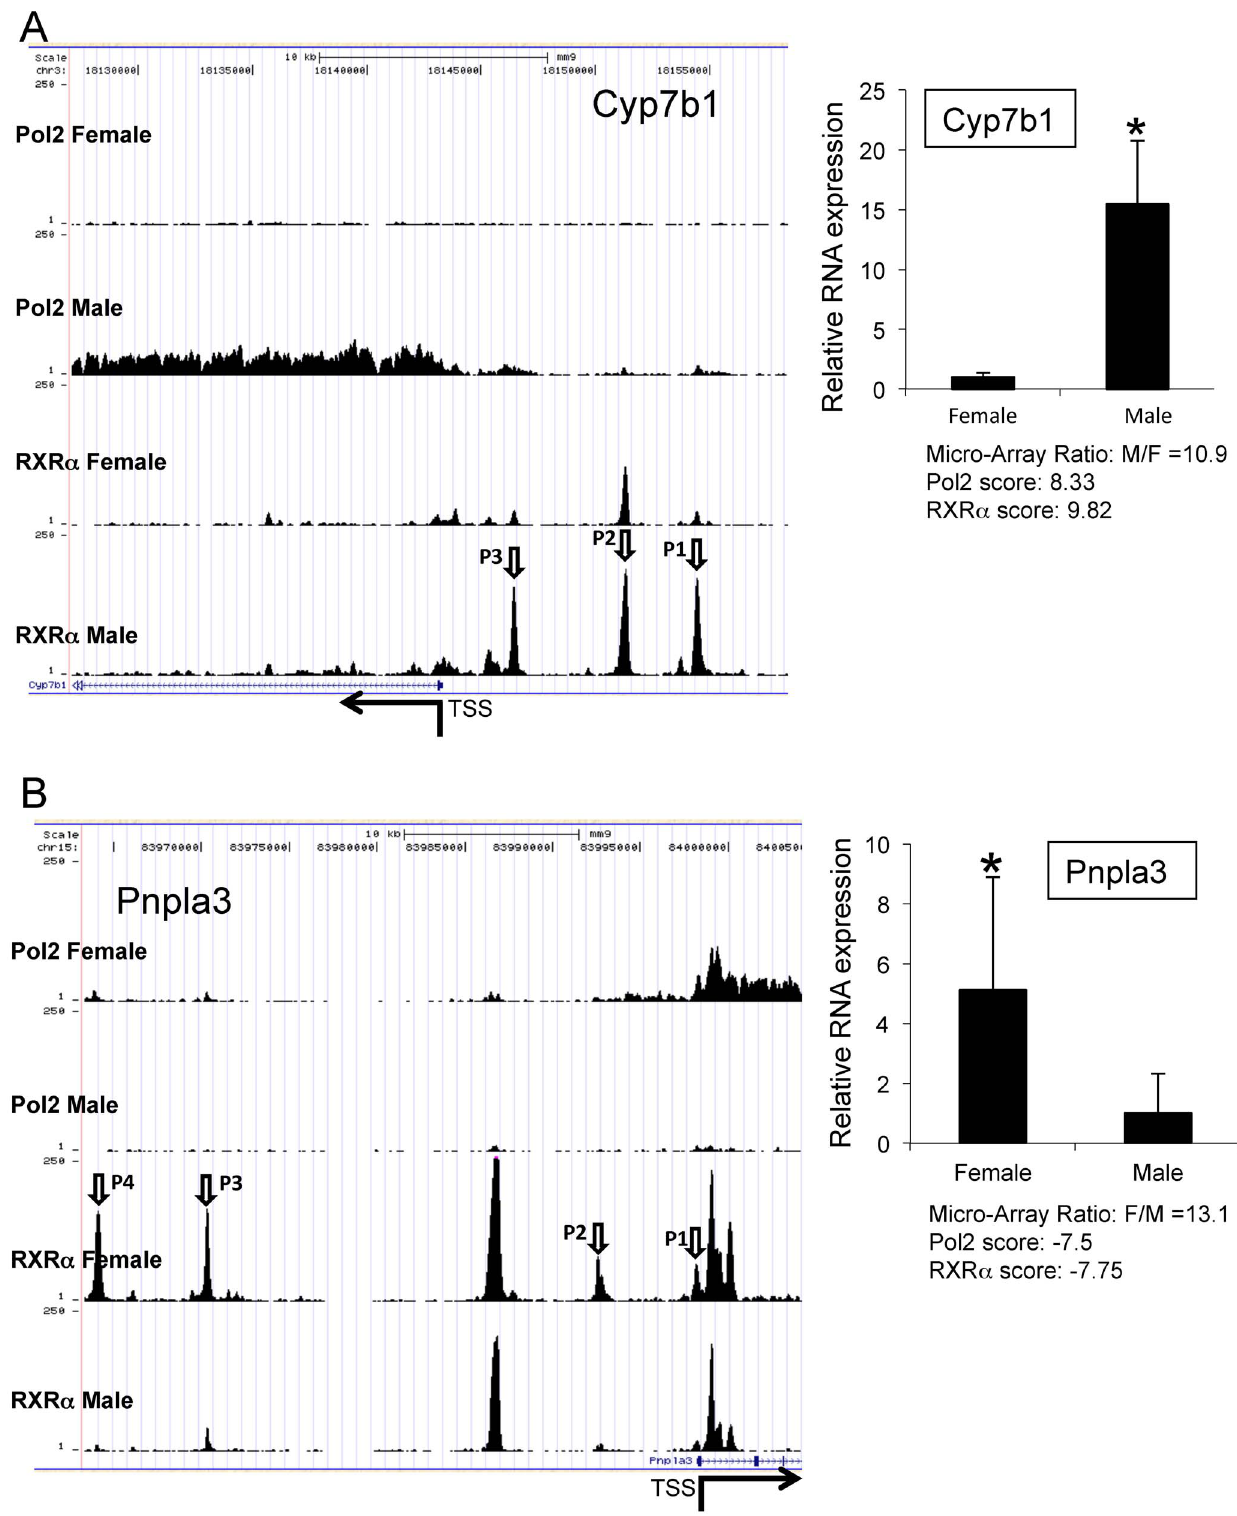
Figure 4. Representatives of gender differential RXR a regulated genes. A) Predominant RXR a and Pol2 binding for Cyp7b1 in male mouse liver. Left-hand panel: Top 2 tracks show Pol2 binding along the Cyp7b1 gene-span in male and female mouse liver. Bottom 2 tracks show RXR a peaks binding upstream of the TSS of Cyp7b1 TSS. Male enriched RXR a peaks are indicated by arrows P1, P2 and P3. Right-hand panel: Sexual dimorphic RNA levels of Cyp7b1 were confirmed by qPCR (n=5–6) (see also Fig. S2 and S3A–G). B) Predominant RXR a and Pol2 binding for Pnpla3 in female mouse liver. Left-hand panel: Top 2 tracks show Pol2 binding along the Pnpla3 gene-span in male and female mouse liver. Bottom 2 tracks show RXR a peaks binding upstream of the TSS of Pnpla3 TSS. Female enriched RXR a peaks are indicated by arrows P1, P2, P3 and P4. Right-hand panel: Sexual dimorphic RNA levels of Pnpla3 were confirmed by qPCR (n=5–6) (see also Fig. S2, S3A–G, S7 and S8). *p , 0.05